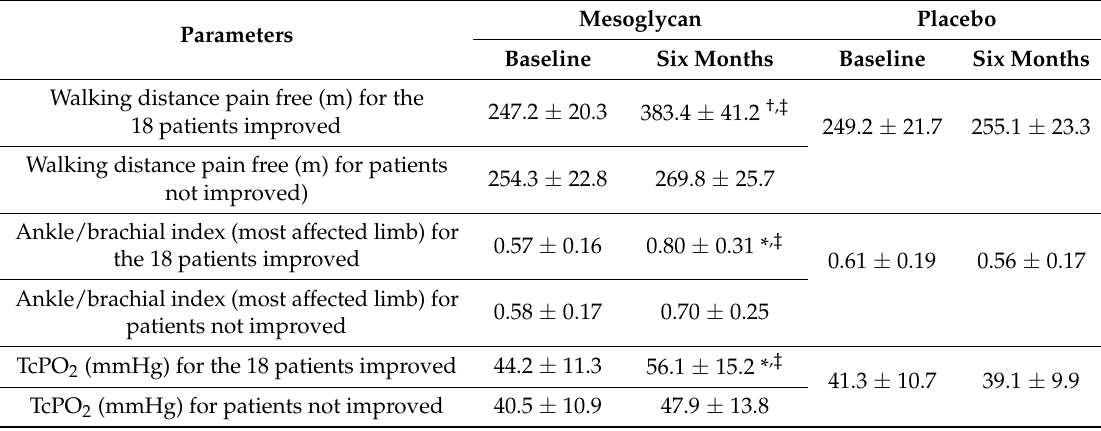
Table 2. C linical parameter results at baseline and at the end of the study. Parameters